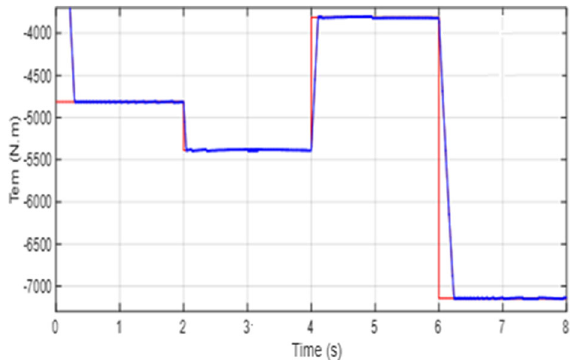
Fig. 16 Electromagnetic torque tracking performance for STW